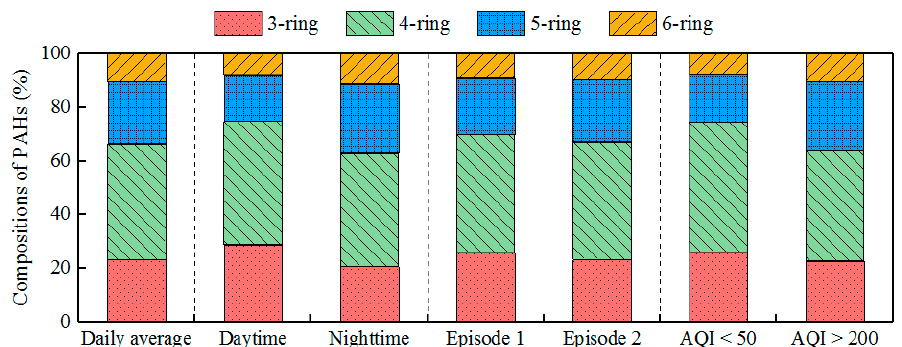
Figure 5. Proportions of PAHs with different rings in the study area during the monitoring period.